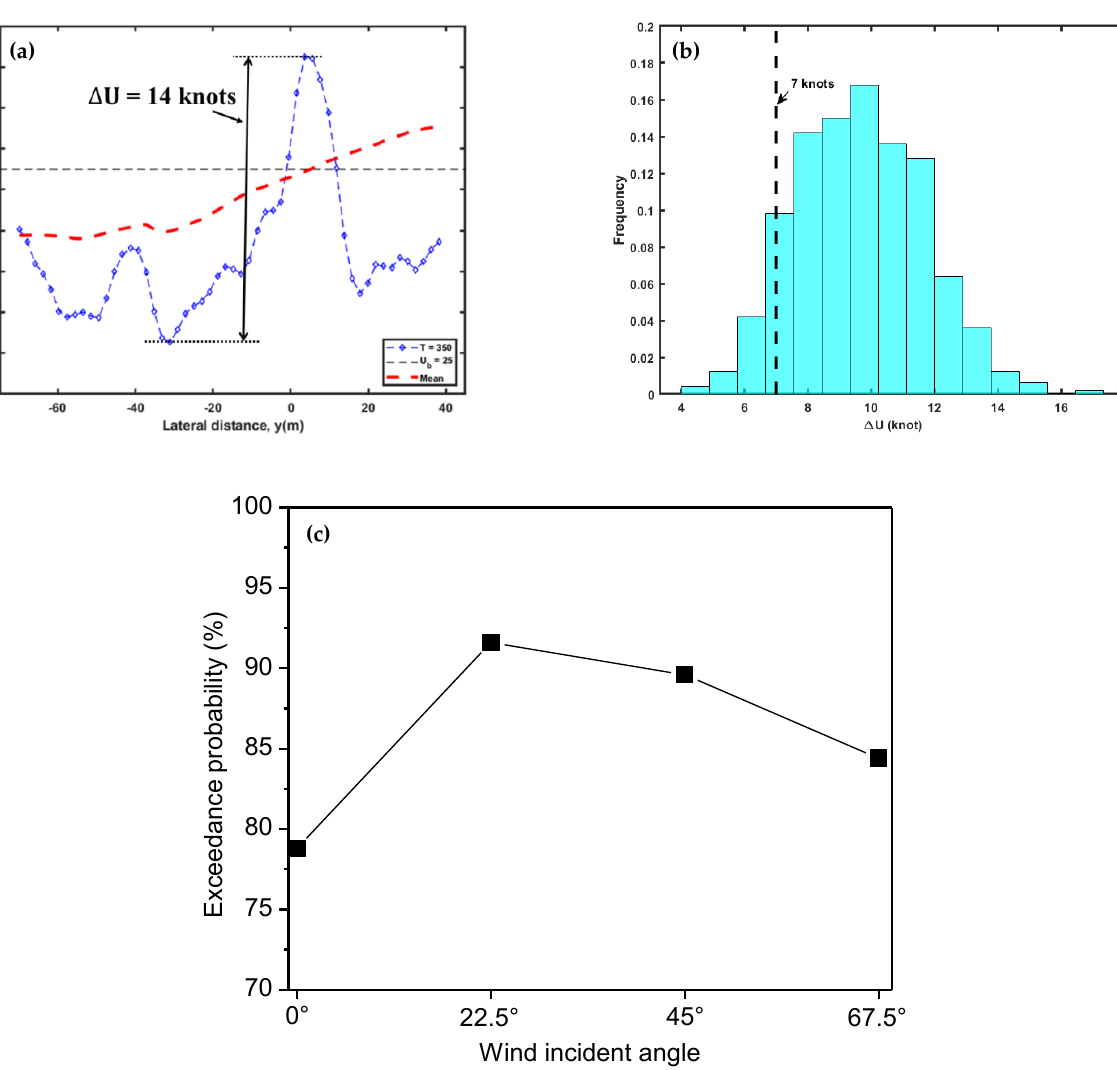
Figure 12. Scenario A: ( a ) maximum velocity difference calculation; ( b ) Probability distribution of maximum velocity dif- ference at wind angle 22.5 ° ; ( c ) Exceedance probability (Pr( ∆𝑈 ≥ 7 )) at different wind angles.